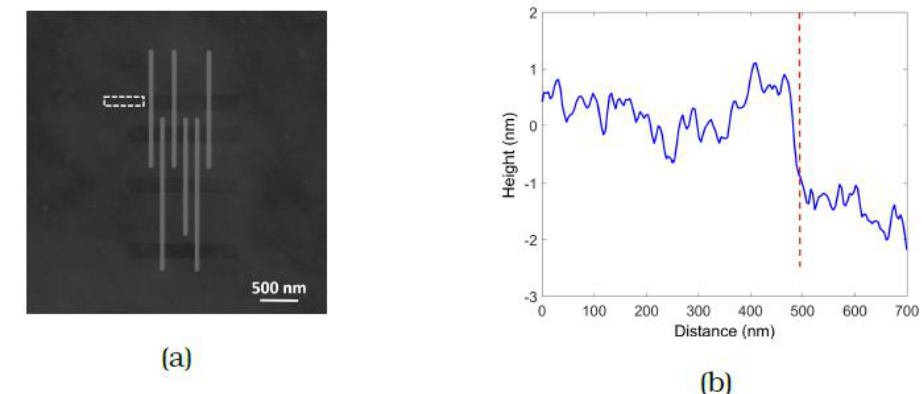
Figure 5. ( a ) AFM image with the dotted lines indicating an area at the edge of the etched region, where the thickness of the carbon film removed is measured from ( b ) to be about 1 nm.